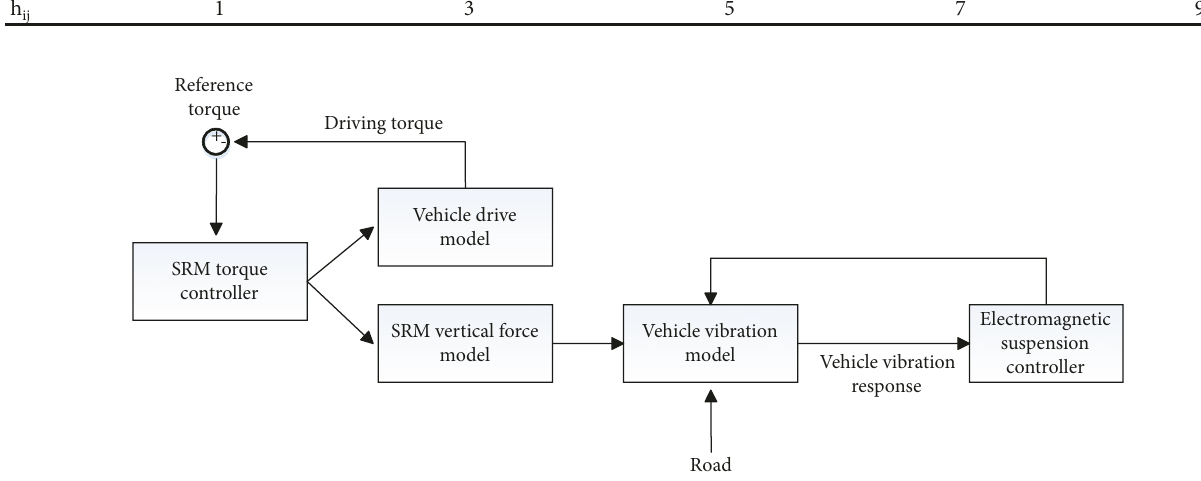
Figure 3: Control diagram for the electromagnetic active